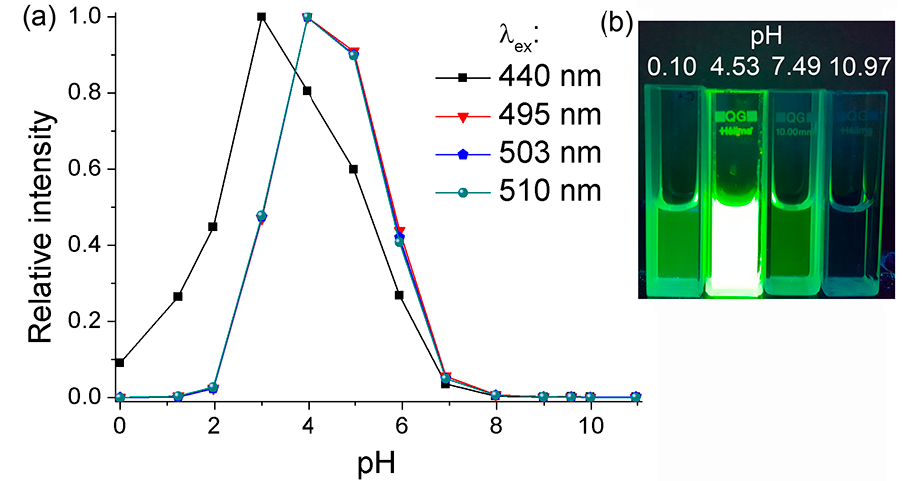
Figure 4. ( a ) Relative intensity of maximum emission of BBDMAF (515 nm) versus pH; each protolytic species was excited at its maximum absorption wavelength. ( b ) Emission image of BBDMAF solutions (concentration of each: 2.5 μ m) illuminated under a UV transilluminator (312 + 365 nm).